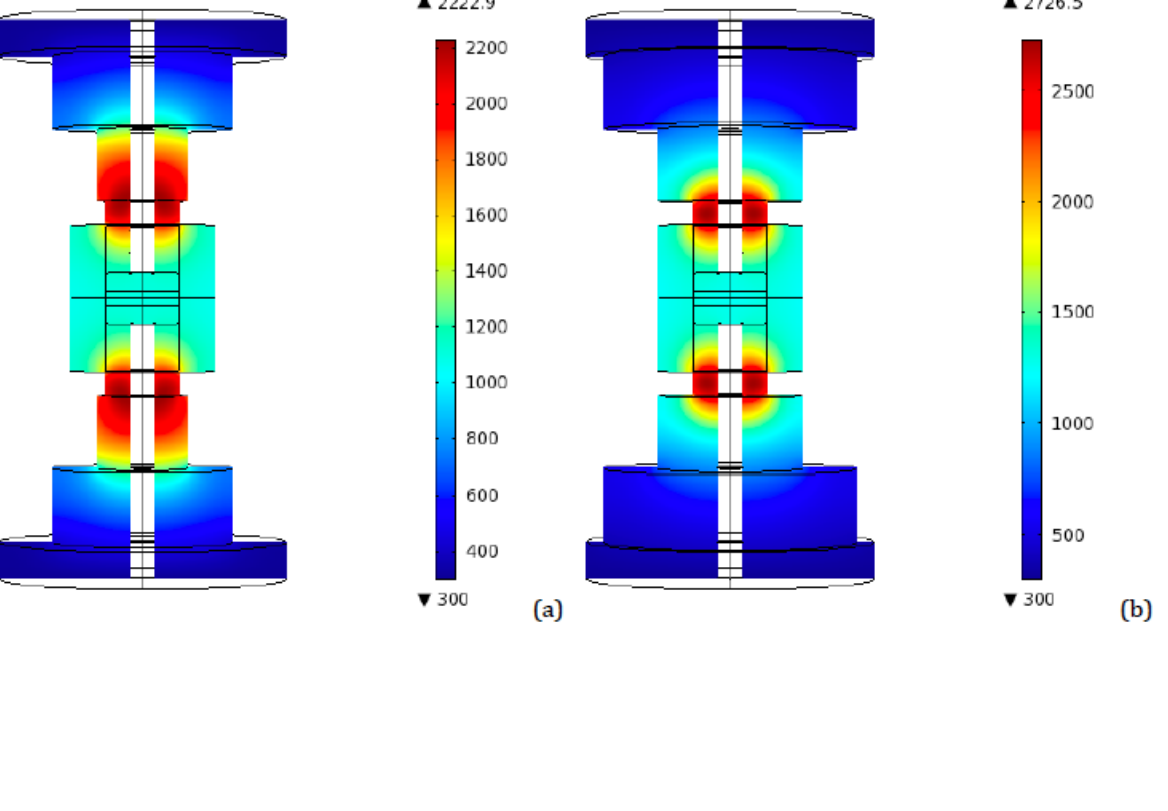
Figure 5. Peak temperature distribution (K)—Ideal contact—two transitional disks configuration. ( a ) Radii: 50 and 25 mm—Heights: 40 mm each; ( b ) Radii: 70 and 40 mm—Heights: 40 mm